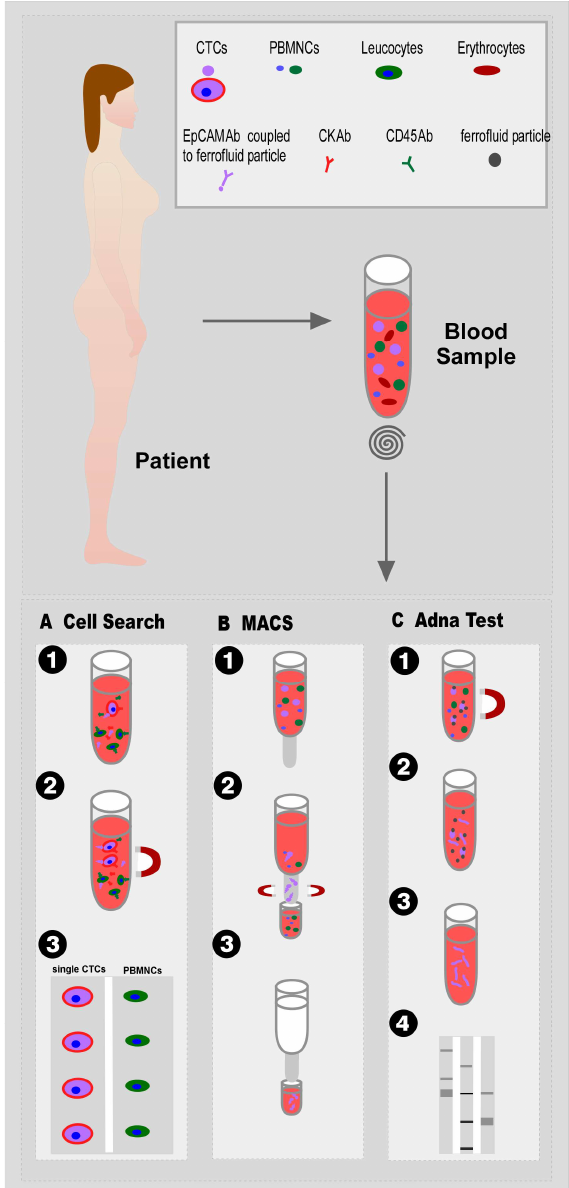
Figure 3. Illustration of CTC isolation methods by magnetic separation using MNPs: ( A ) The CellSearch system includes the enrichment of CTCs with ferrofluid particles linked with anti-EpCAM antibodies, magnetic separation of labeled cells and evaluation by immunofluorescent staining. ( B ) The principle of magnetic activated cell sorting (MACS) by using superparamagnetic Fe NPs within a magnetized steel wool column. ( C ) The process of AdnaTest describes the immunomagnetic enrichment of CTCs via epithelial and tumor-specific antigens. Potential CTCs are separated from peripheral blood mononuclear cells (PBMCs) and lysed in order to analyze the CTC gene expression via multiplex PCR.